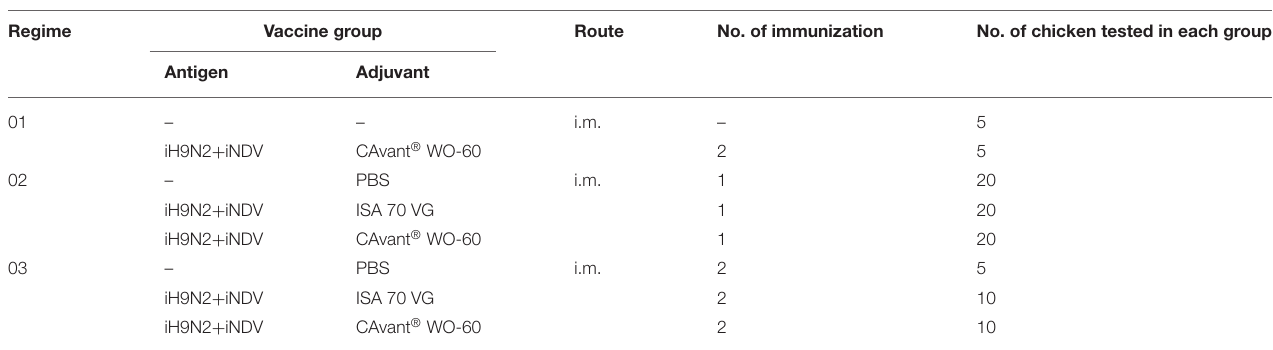
TABLE 2 | Groups for the chicken experiments.